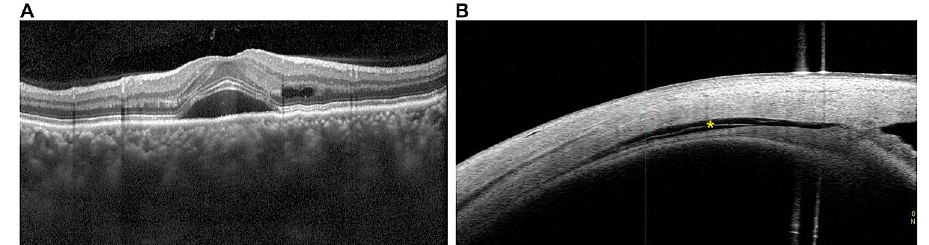
Figure 4. We observed anterior choroidal effusion (asterisk, B ) in a CSC eye with pachychoroid ( A ).